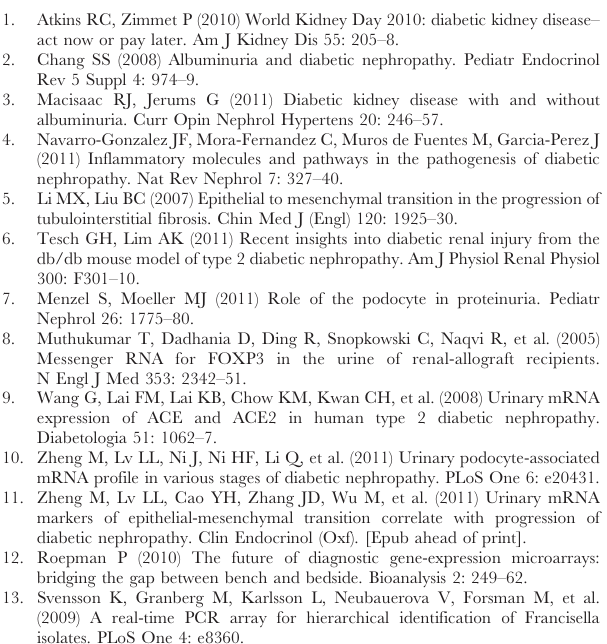
Table S1 Gene Table and Transcripts Detected by the